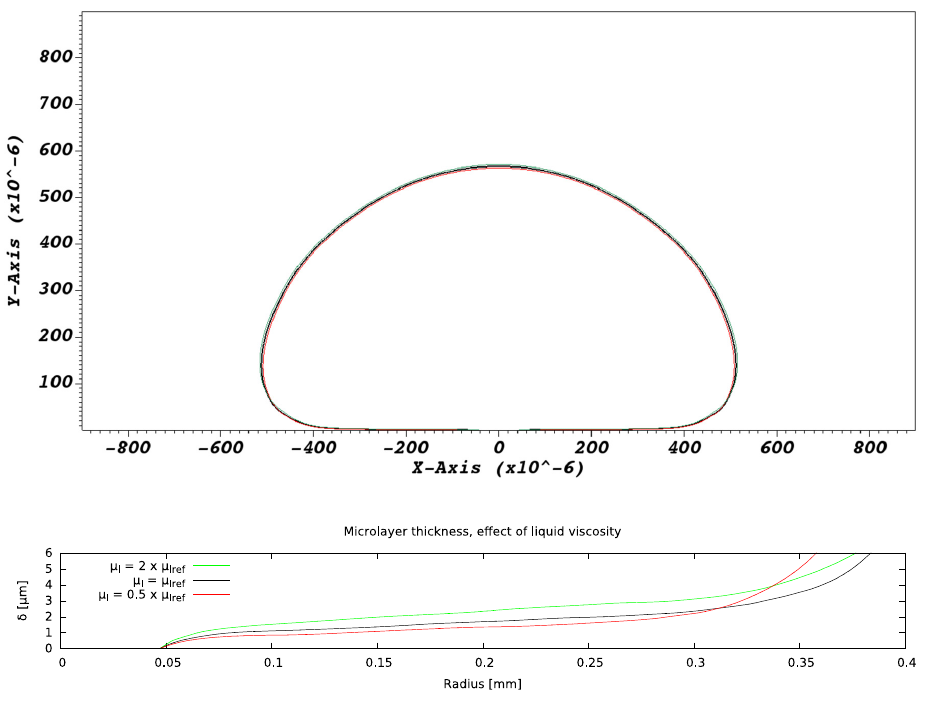
Figure 12. Effect of liquid viscosity on microlayer formation. Bubble and microlayer shapes are compared at the same instant of time into bubble growth.